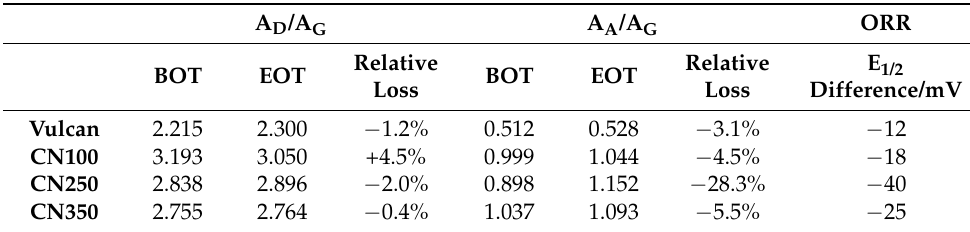
Table 1. Postmortem Raman investigation results. BOT = beginning of test; EOT = end of test. The electrochemical stability was performed for 6 h (see Experimental section). If the relative loss has a negative sign, then it can be considered as a